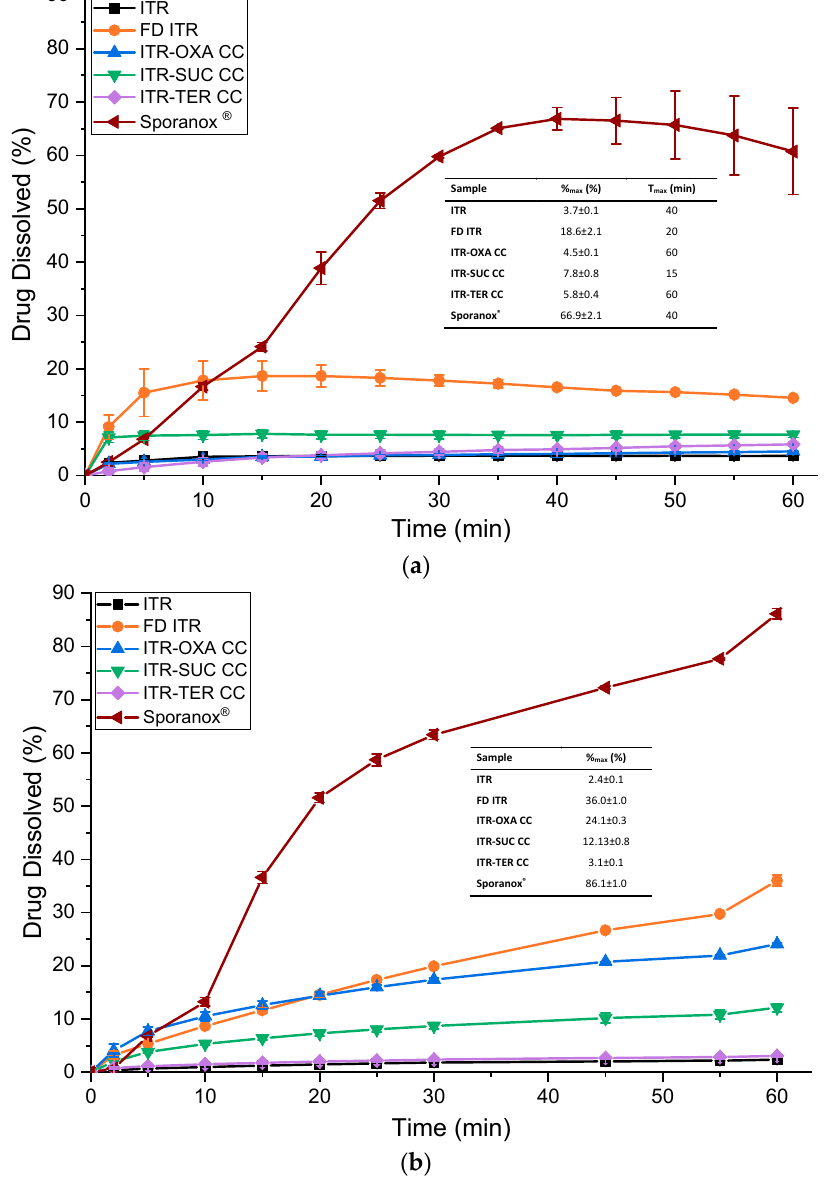
Figure 12. ( a ) Dissolution profile of Sporanox ® and the physical mixtures of ITR and cocrystals with lactose monohydrate in a 1:6 ratio ( w / w ) of the active pharmaceutical ingredient (API) and excipient; ( b ) dissolution profile of Sporanox ® and the ITR, FD IDR, ITR–OXA, ITR–SUC and ITR–TER mixed with excipients present in the Sporanox ® capsule. T max —the time to reach the maximum percent (% max ) of the dissolved drug, CC—cocrystal.